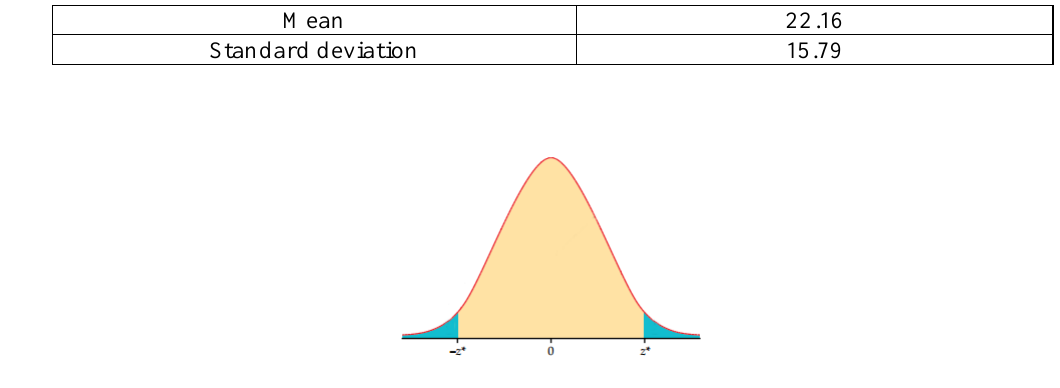
Figure 5 . Normal distribution z